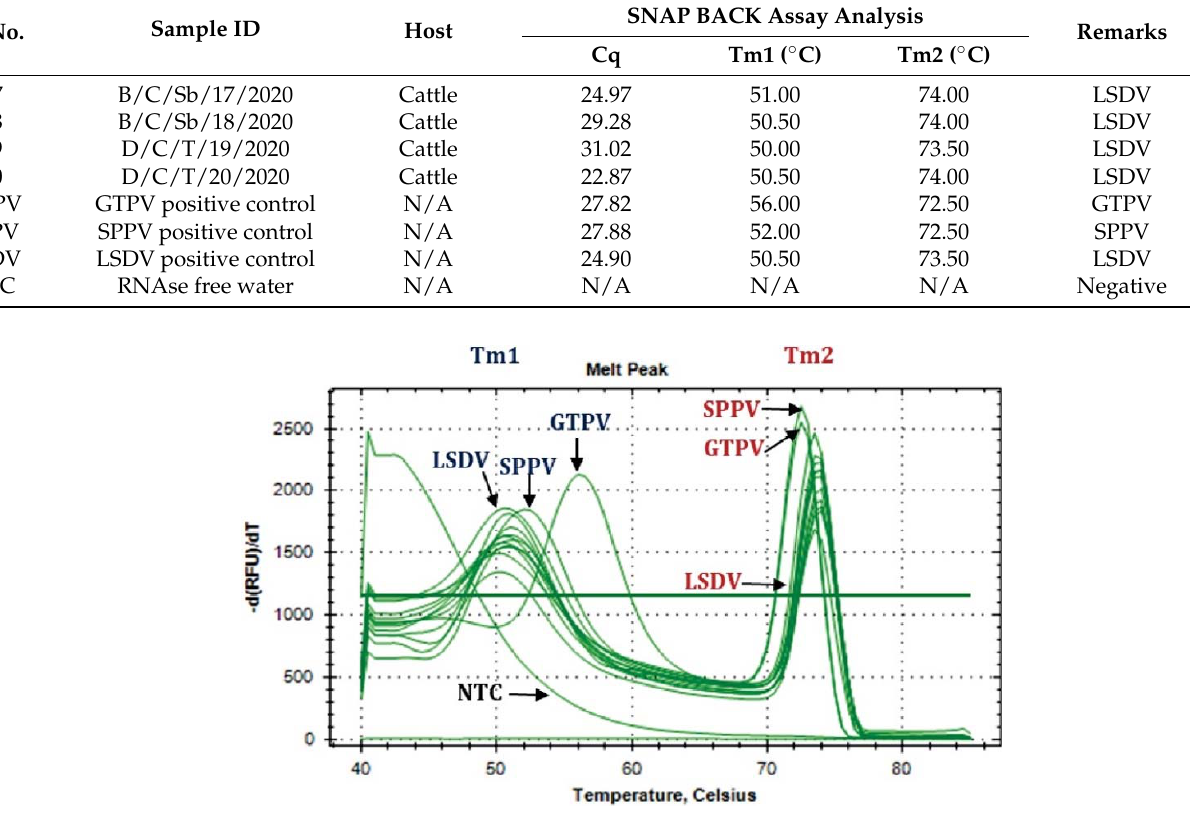
Figure 3. Melting peaks (Tm) of samples from Nepal compared to the positive control of GTPV, SPPV, and LSDV. Both melting temperatures for the snapback stem (Tm1) and the PCR amplicons (Tm2) are